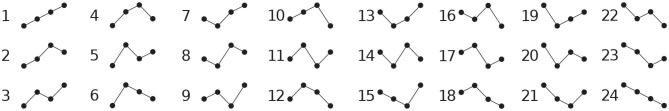
All 24 ordinal patters of length w = 4.